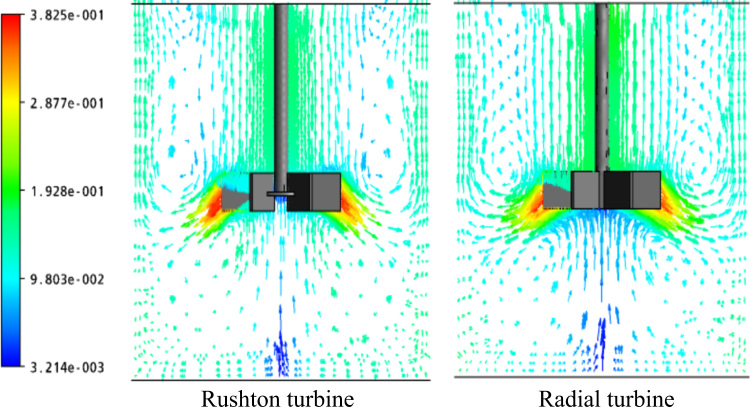
Velocity vectors for Re=2.9×104, at R*=0.